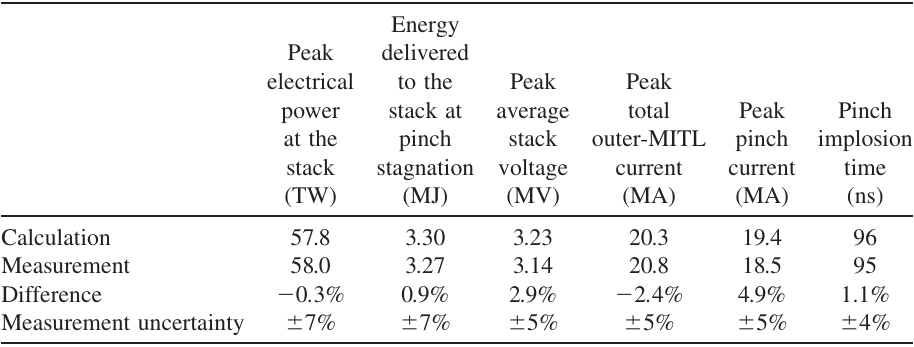
TABLE VIII. Comparison of TL -model calculations with measurements taken on the Z accelerator. (The calculations listed here are a subset of those given for MITL-design II in Table VI.) The measurements are average values of data acquired on four nominally identical Z shots. The load was a z pinch with a 1-cm length, 1-cm initial radius, and 5.88-mg total mass. The Marx-charge voltage on these shots was 90 kV.